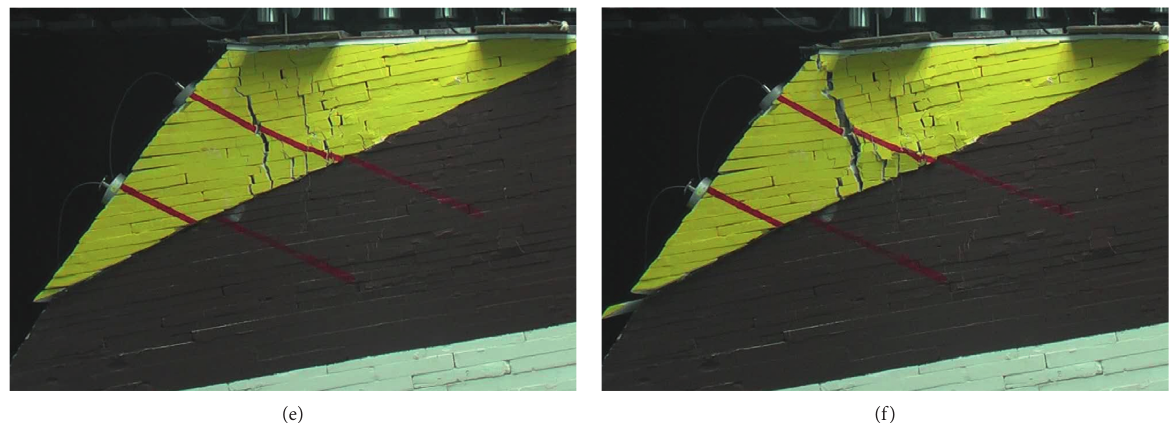
Figure 12: Images of the model after loading and stabilization at all levels. (a) Before loading. (b) Level 1 load (0.3MPa). (c) Level 2 load (0.5MPa). (d) Level 3 load (0.7MPa). (e) Level 4 load (1.1 MPa). (f) After destruction.